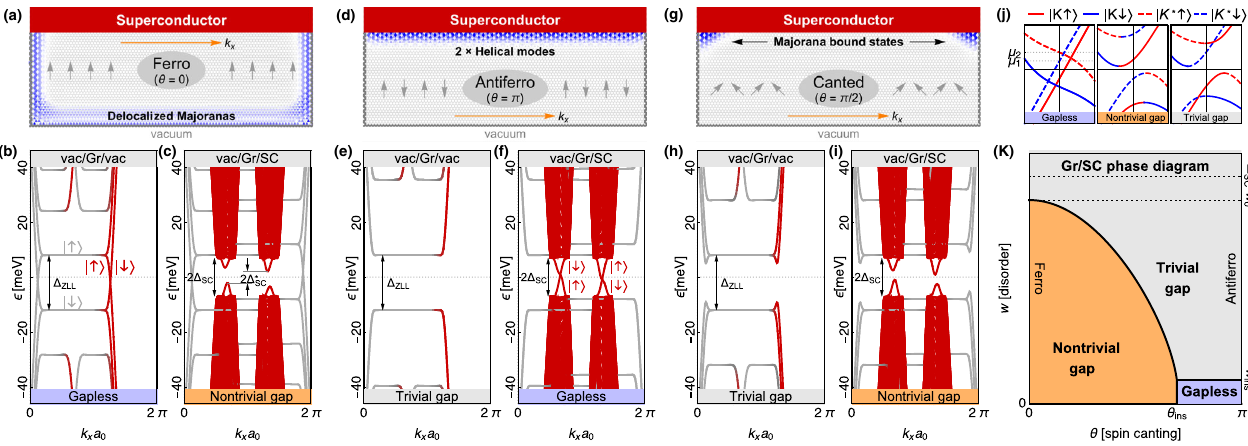
10 6 m=s ) in the quantum FIG. 1. Sketch, band structure, and phase diagram of a 350-nm-wide graphene sample (Fermi velocity v F ¼ 1 T) in various configurations. The chemical potential (dotted line) is tuned within the gap Hall regime (out-of-plane field B z ¼ Δ ≈ 20 meV of the zero Landau level, which has ferromagnetic (a – c), antiferromagnetic (d – f), or canted antiferromagnetic ordering ZLL (g – i) due to electronic interactions. The band structures under each sketch correspond to an infinite graphene ribbon surrounded by vacuum (vac/Gr/vac panels) or coupled to a superconductor of gap Δ (chosen to be large, around 7 meV, for visibility) along the top SC edge as in the sketches (vac/Gr/SC panels, Nambu bands). Bands in red correspond to eigenstates localized at the top edge of the ribbon. The zero-energy local density of states is shown in blue in each sketch. (j) Low-energy band structure of states along a graphene- superconductor interface folded onto the Γ point, in the gapless (left panel, zoom of panel f), nontrivially gapped (middle panel, canted order), and trivially gapped (right panel, with strong intervalley scattering) phases. (k) Phase diagram of said interface, computed from its low-energy effective Hamiltonian (see text), as a function of magnetic angle θ and intervalley coupling w . The three possible phases are shown, bounded by threshold values w 0 , w , and θ (see main ins ins